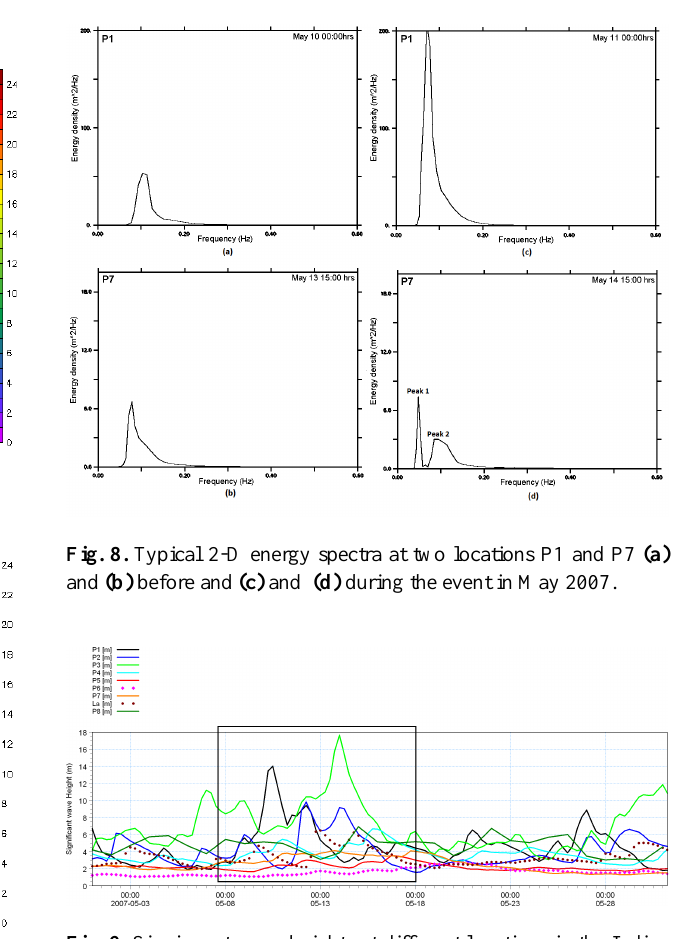
Fig. 9. Significant wave heights at different locations in the Indian Ocean during May 2007 (to describe the impact of south Indian Ocean swells in the Arabian Sea and the Bay of